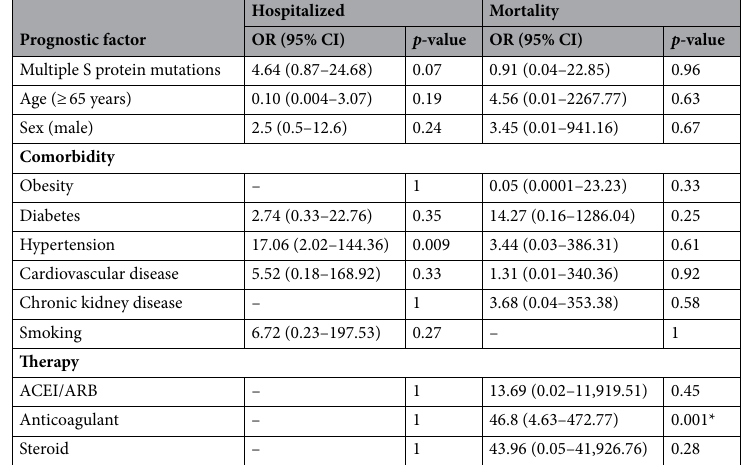
Table 5. Multivariate analysis of the association between prognostic factors and outcomes of patients with COVID-19. *Significant ( p < 0.05). ACEI angiotensin-converting enzyme inhibitors, ARB angiotensin receptor blocker, CI confidence interval, OR odds